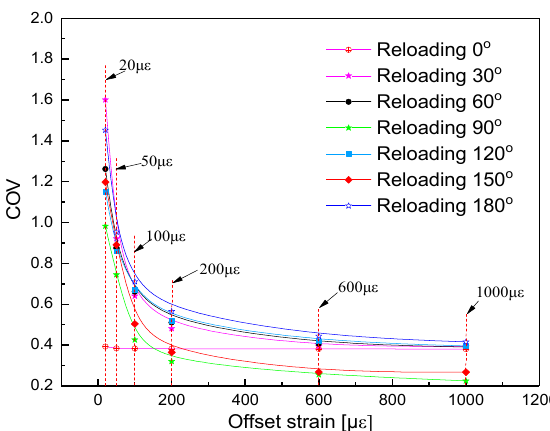
Figure 14. Variation curves of COV (Here, COV was defined as the ratio of the standard deviation S of the accumulated effective plastic strain increment to its average absolute value ) for the equivalent plastic strain increment vs offset strain along different reloading paths at unloading point D-O D after 30 tension-compression cycles.